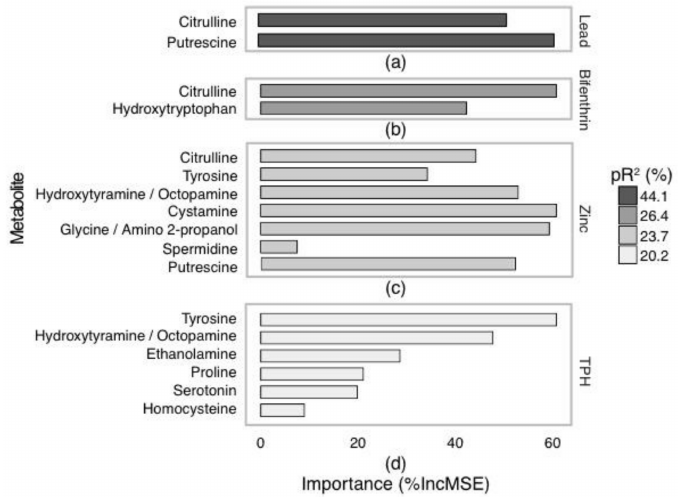
Figure 4. Relative importance of LC-MS amine metabolites selected by model for association with ( a ) lead, ( b ) bifenthrin, ( c ) zinc and ( d ) total petroleum hydrocarbons (TPH) in Procladius villosimanus collected from 21 wetlands. Data were modelled with a regression random forest model. Fills represent the goodness of fit of each model. Abbreviations: pR 2 , pseudo-R 2 ; %IncMSE, percent increase in mean squared